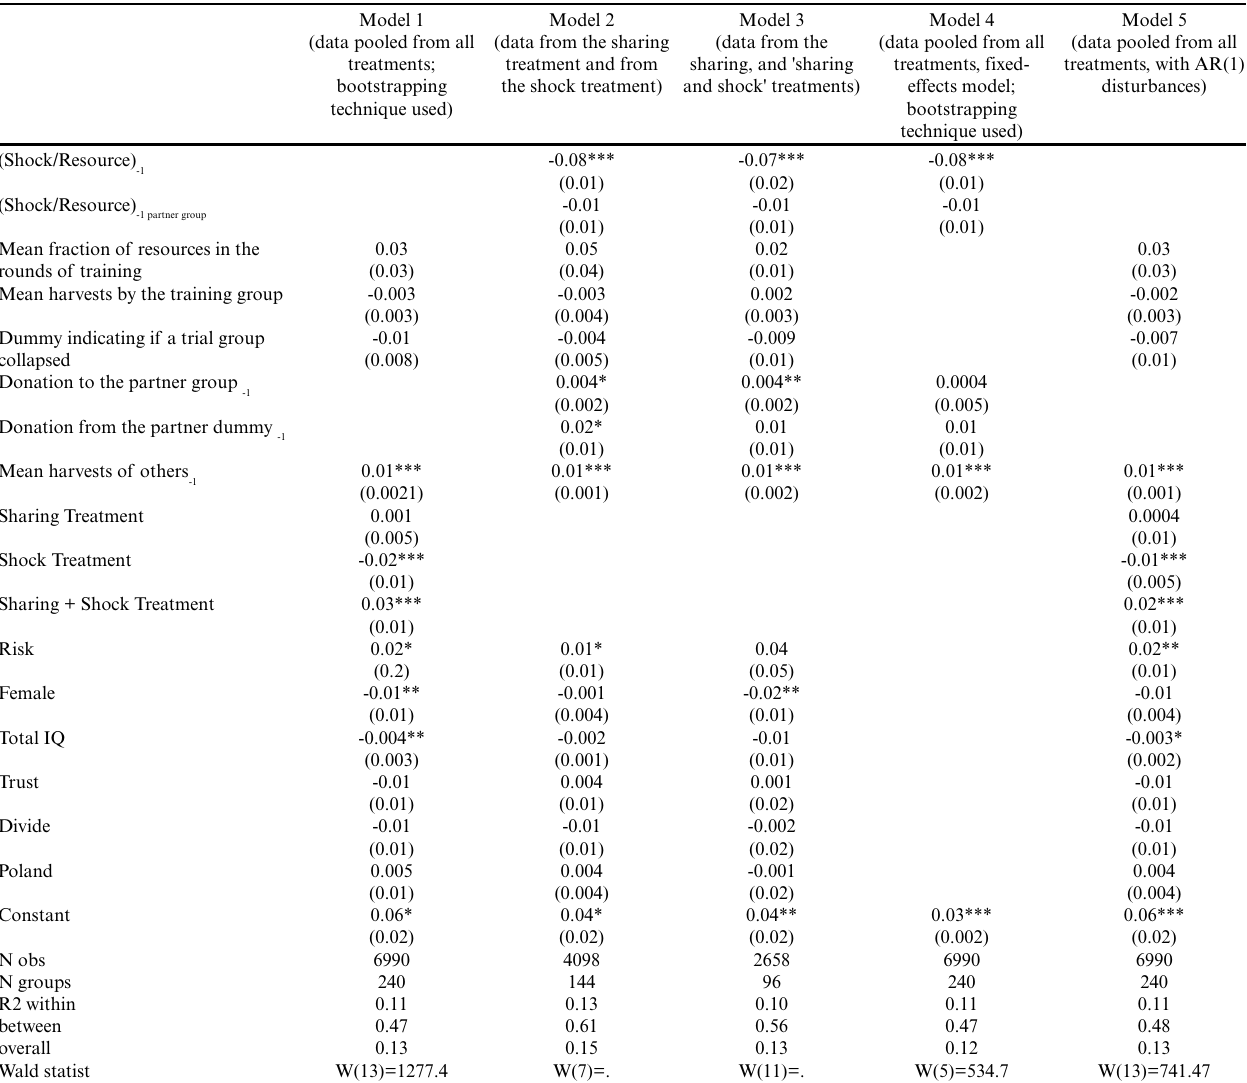
Table 3 . The fraction of resources harvested by subjects (standard deviations in